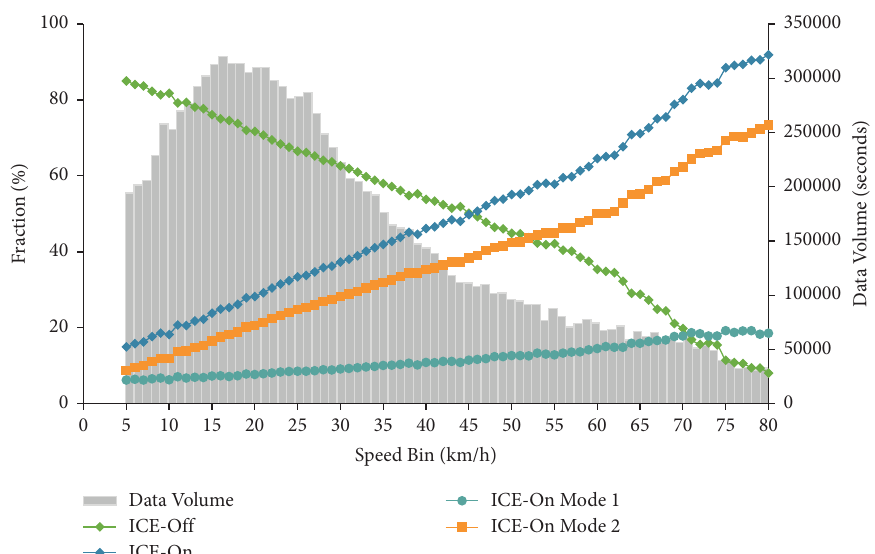
Figure 7: Data size in HEV ICE operating